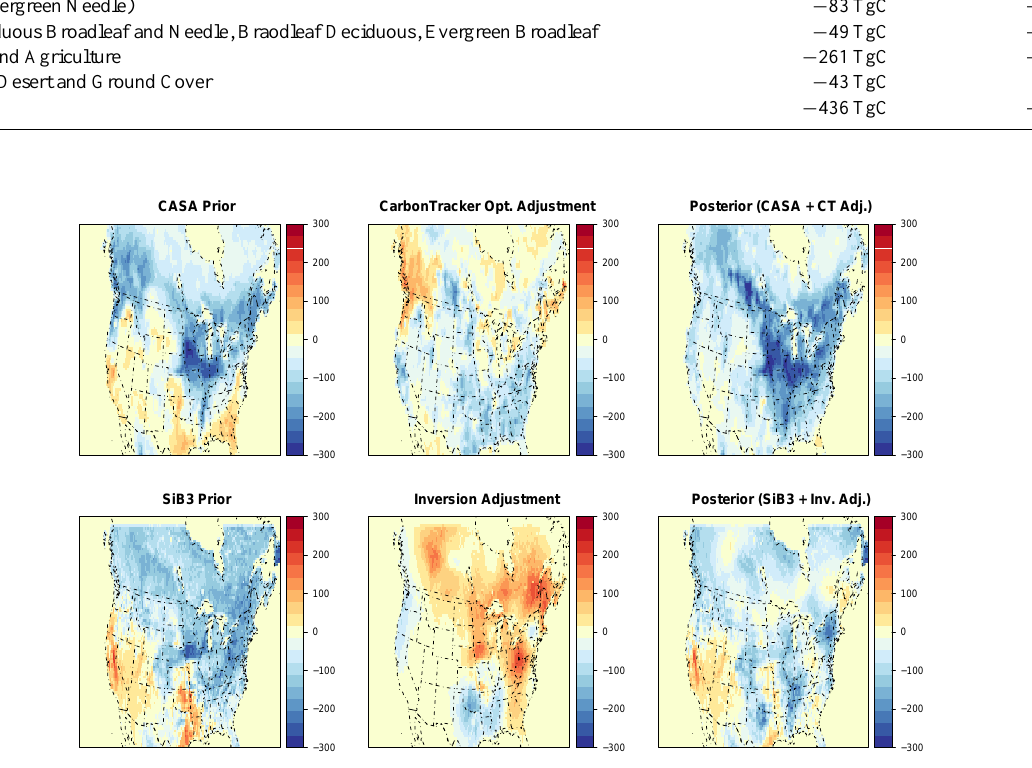
Fig. 10. July-August-September comparison. Top panels concern CarbonTracker and lower panels concern our inversion. Left panels show a priori NEE, middle panels show inversion adjustment, and right panels show a posteriori